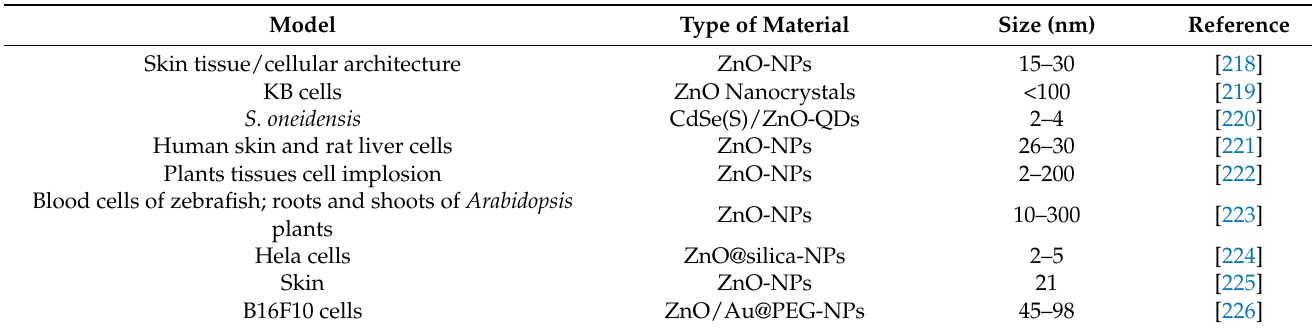
Table 9. Bioimaging Uses of